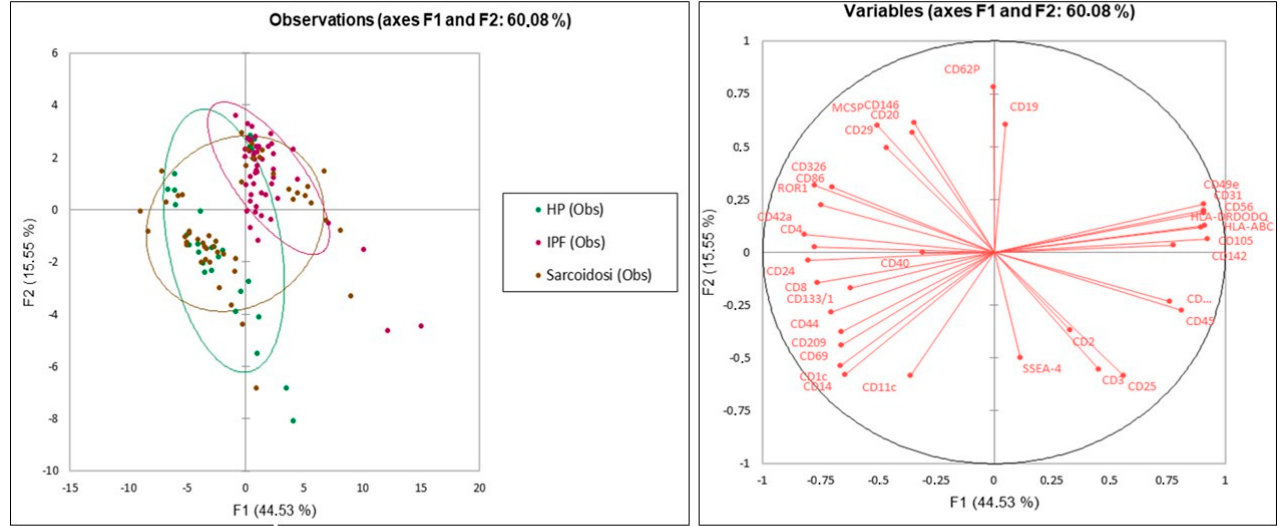
Figure 2. Unsupervised principal component analysis (PCA) to distinguish the three groups (IPF, HP and sarcoidosis) on the basis of 37 surface exosome markers with total variance of 60.08%. Figure 4 shows the main markers expressed exclusively in IPF (CD105, CD142, CD31, CD49e and CD56), only in HP (CD86, MCSPand CD24) as well as those markers that are common between HP and sarcoidosis (CD11c, CD133/1, CD14, CD1c, ROR1, CD209, CD4, CD40, CD44, CD8) and in both BAL samples of IPF and sarcoidosis (CD19 and CD45) Heat map analysis (Figure 3a) showed that the significant EV surface markers may BAL be expressed in clusters of IPF, HP and sarcoidosis. The median APC values of each sig- nificant different surface marker in IPF, HP and sarcoidosis were reported in Figure 3b.